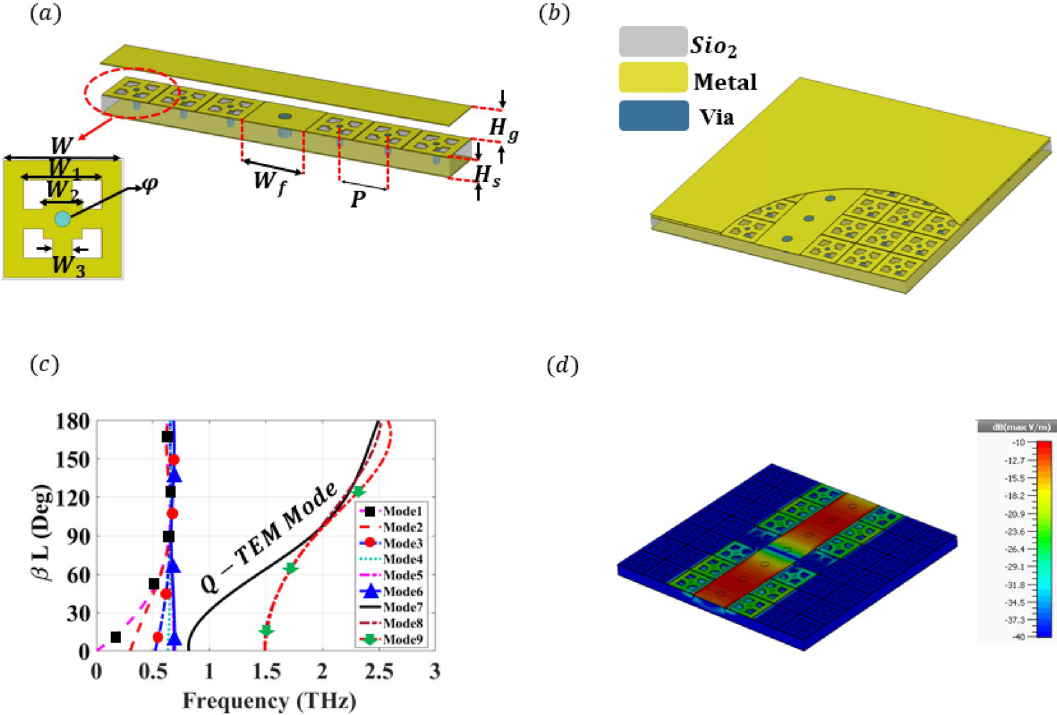
Figure 2. 3-D view of the proposed terahertz PRGW transmission line and simulated results of the proposed terahertz PRGW transmission line. ( a ) The 3D view of a PRGW section used to construct the PRGW line. Physical parameters are sets as ridge width W f = 40 μm, period P = 31 μm, substrate height H s = 10 μm, and air gap height H g = 2 μm. Unit cell parameters and dimensions are chosen as W = 30 μm, W 1 = 20 μm, W 2 = 10 μm, W 3 = 5 μm, and via radius φ = 4 μm. ( b ) 3D geometry of PRGW line. This line is consisting of a metal strip connected to the bottom ground through vias, which is surrounded by EBG unit cells covered by a ground plane. ( c ) Dispersion diagram of the PRGW section from the Eigenmode solver of CST. ( d ) Electric field distribution for the propagating mode at 1 THz extracted from the transient solver of